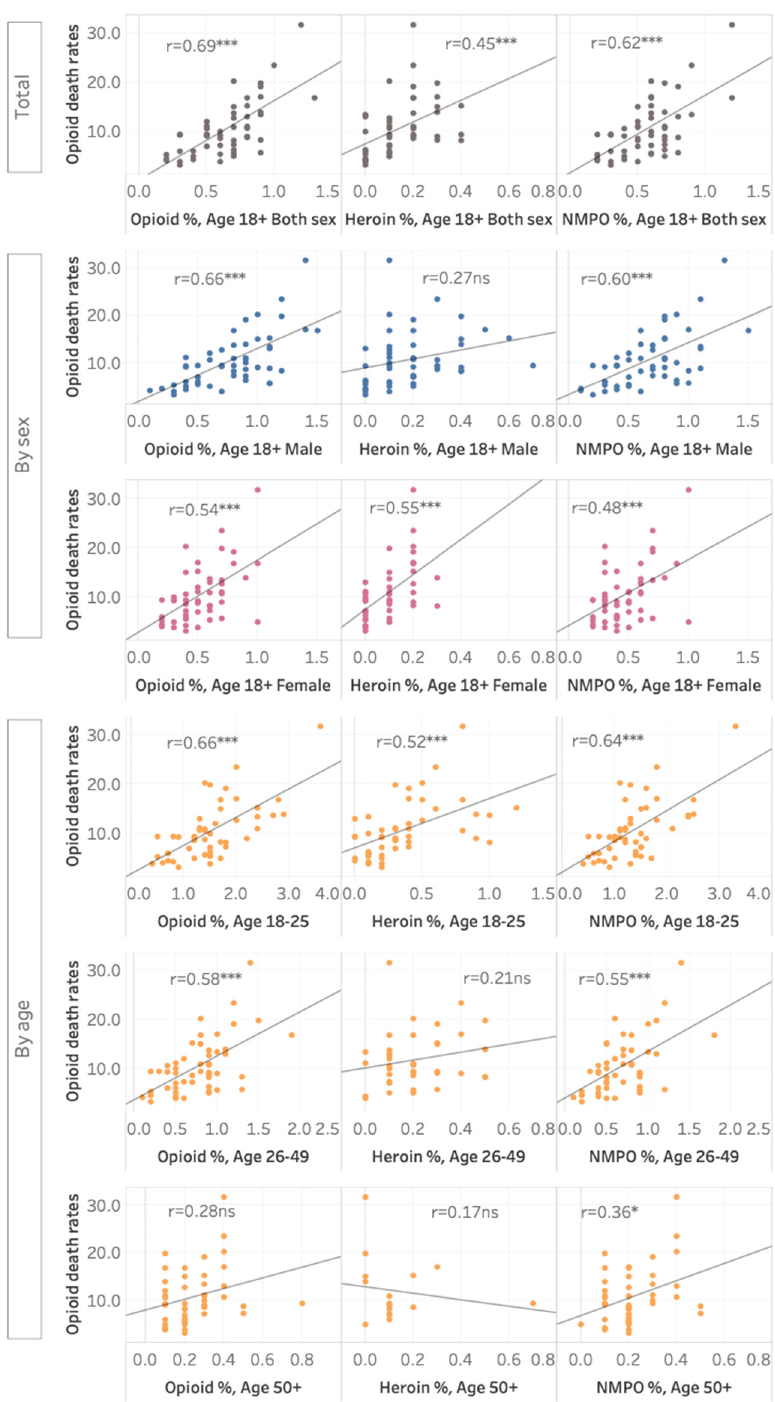
Figure 1. State-level prevalence of opioids dependence, heroin dependence, and NMPO depend- ence. An interactive data visualization tool is available online (https://public.tableau.com/app/pro- file/janni.leung/viz/Opioid-relateddeathratesbystate-levelprevalenceofopioidheroinandnon-medi- calprescriptionopioiddependenceintheUSA-LeungJ2022/Dashboard (accessed on 15 December 2021)). * p <0.05, *** p <0.001.